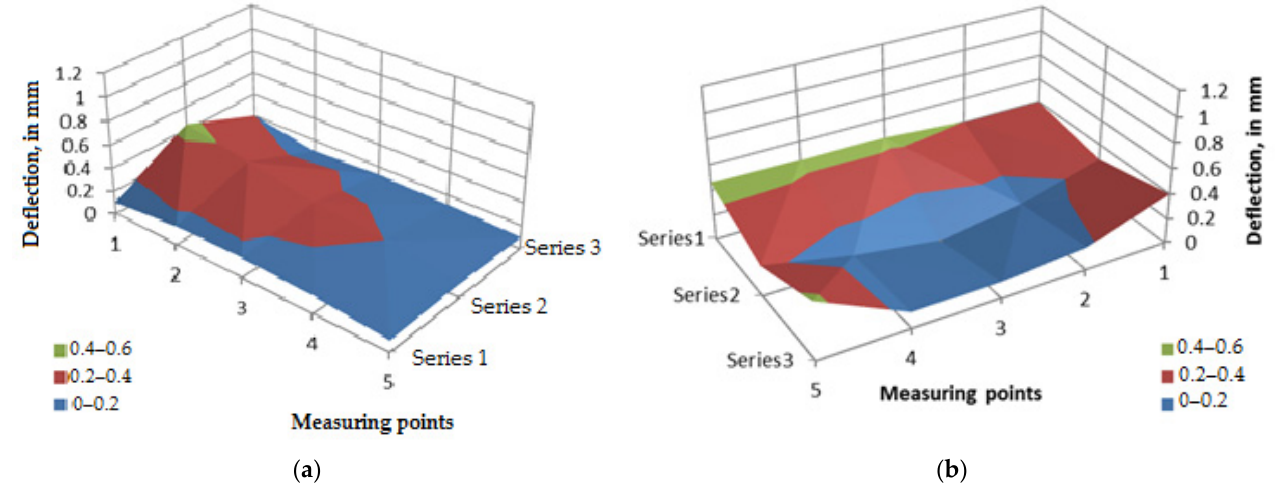
Figure 6. Deflection values and warpage of blockboard with veneer (V) faces tested in the bathroom: ( a ) at the beginning of the experiment; ( b ) after three months of exposure in the bathroom.